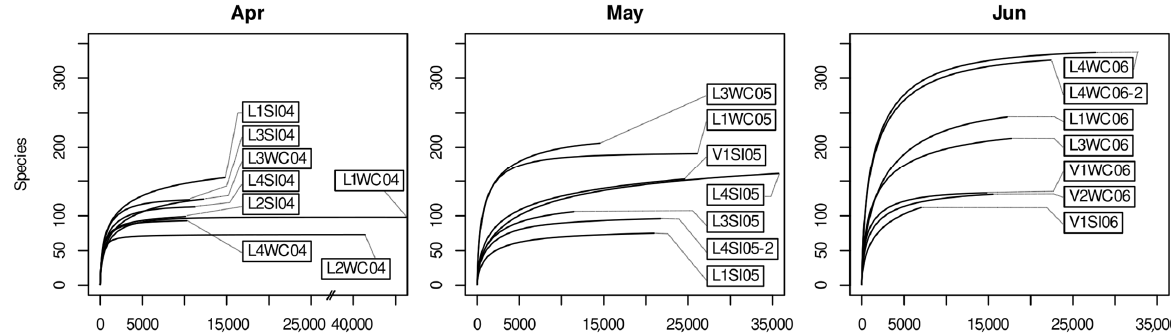
Figure 1. Rarefaction curves of microeukaryotic communities. Curves are grouped by the month of sampling.